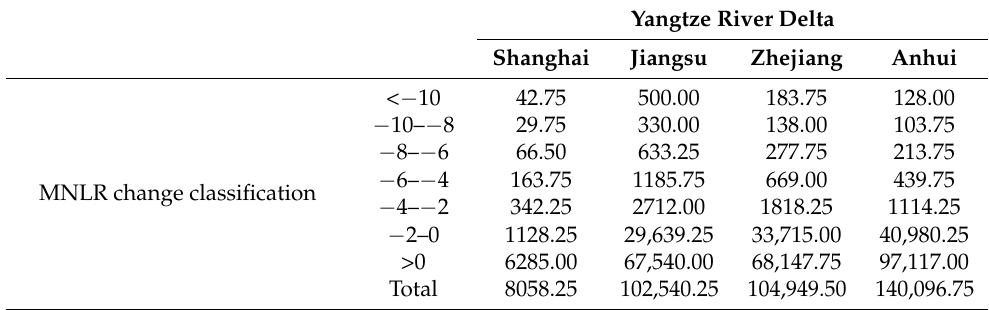
Table 2. Statistics of MNLR change classification area in April 2019 of Yangtze River Delta (km 2 ).